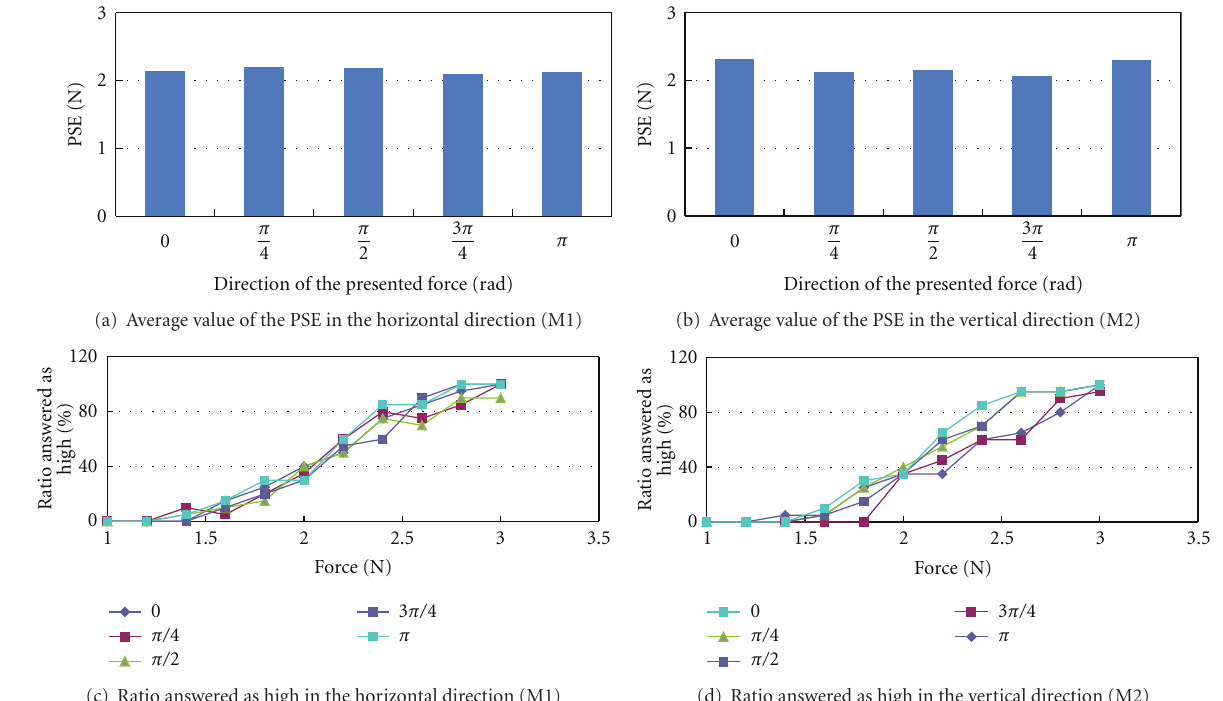
Figure 11: Measurement results of the PSE at each direction of the presented